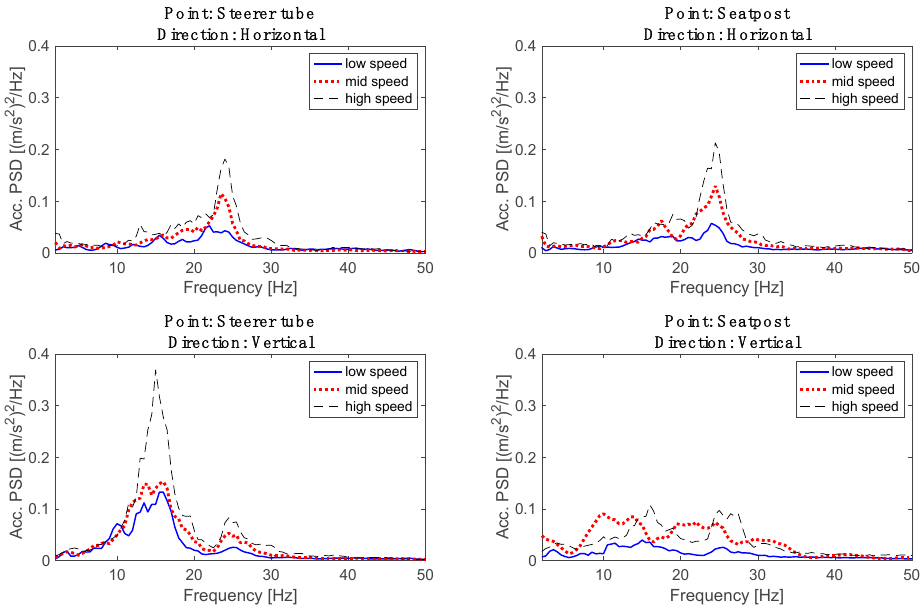
Figure 3. Acceleration PSDs of Bicycle